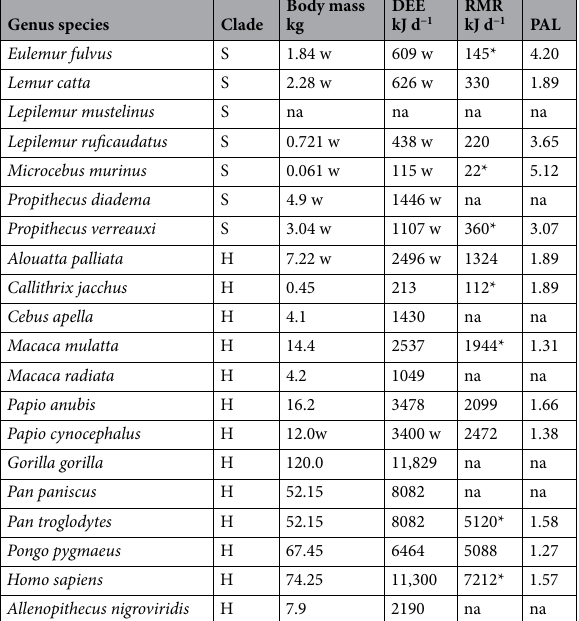
Table 1. Metabolic requirements in selected strepsirhine (S) and haplorhine (H) primates. DEE: daily energy expenditure. RMR: resting metabolic rate adjusted for the average body mass of individuals measured in DEE studies. Prediction equation and species deviation from the RMR:mass trendline (n = 40 spp) were obtained in the present study (PGLS regression: LnRMR, in kJ.d -1 = 3.89 + 0.71* LnBody mass, in g). PAL: estimated physical activity level, i.e. the DEE-to-RMR ratio. *: equivalent to basal metabolic rate (BMR).. DEE data for Pan paniscus and P. troglodytes were pooled in the source paper. References: see “Methods”. w: wild.